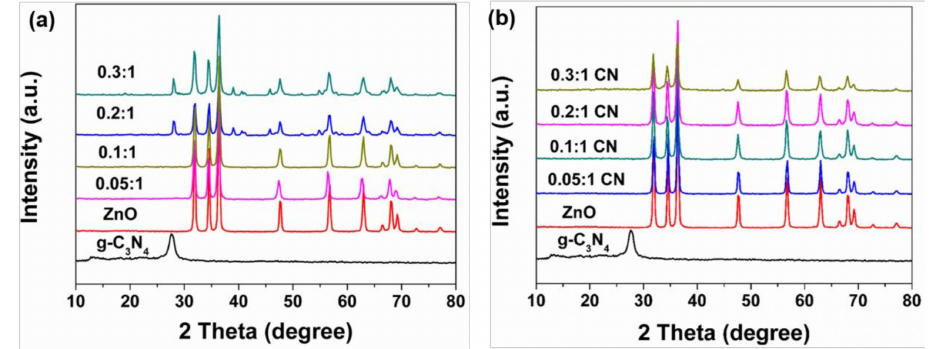
Figure 1. XRD patterns of pure g-C 3 N 4 , as-prepared ZnO nanorods, with ( a ): g-C 3 N 4 /ZnO ( x :1), and ( b ) g-C 3 N 4 /ZnO ( x :1